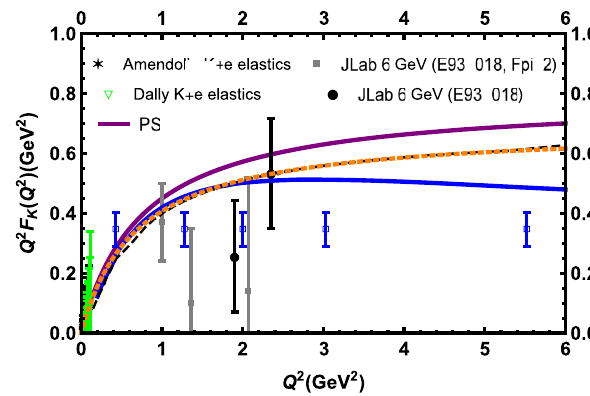
Fig. 6 The vacuum electromagnetic form factor of Kaon in terms of Q 2 considering all the uncertainties of the input parameters